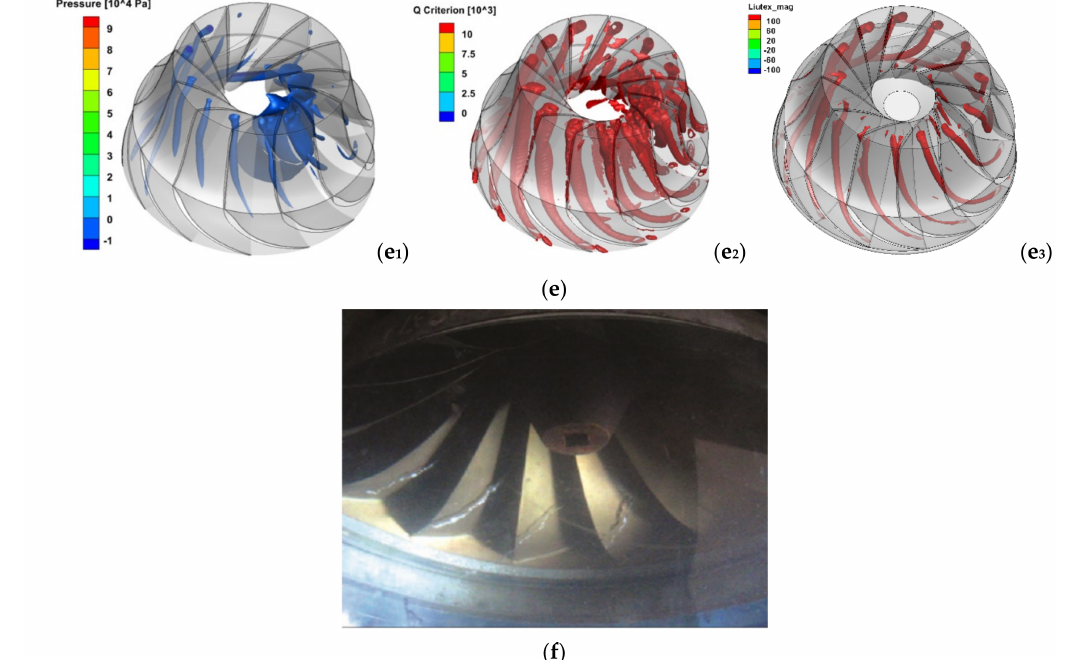
Figure 12. Inter-blade passage vortex. ( a ) α = 13.50 mm (small opening condition): ( a 1 ) Pressure iso-surface method, ( a 2 ) Q criterion, ( a 3 ) Liutex; ( b ) α = 26.17 mm: ( b 1 ) Pressure iso-surface method, ( b 2 ) Q criterion, ( b 3 ) Liutex; ( c ) α = 38.05 mm: